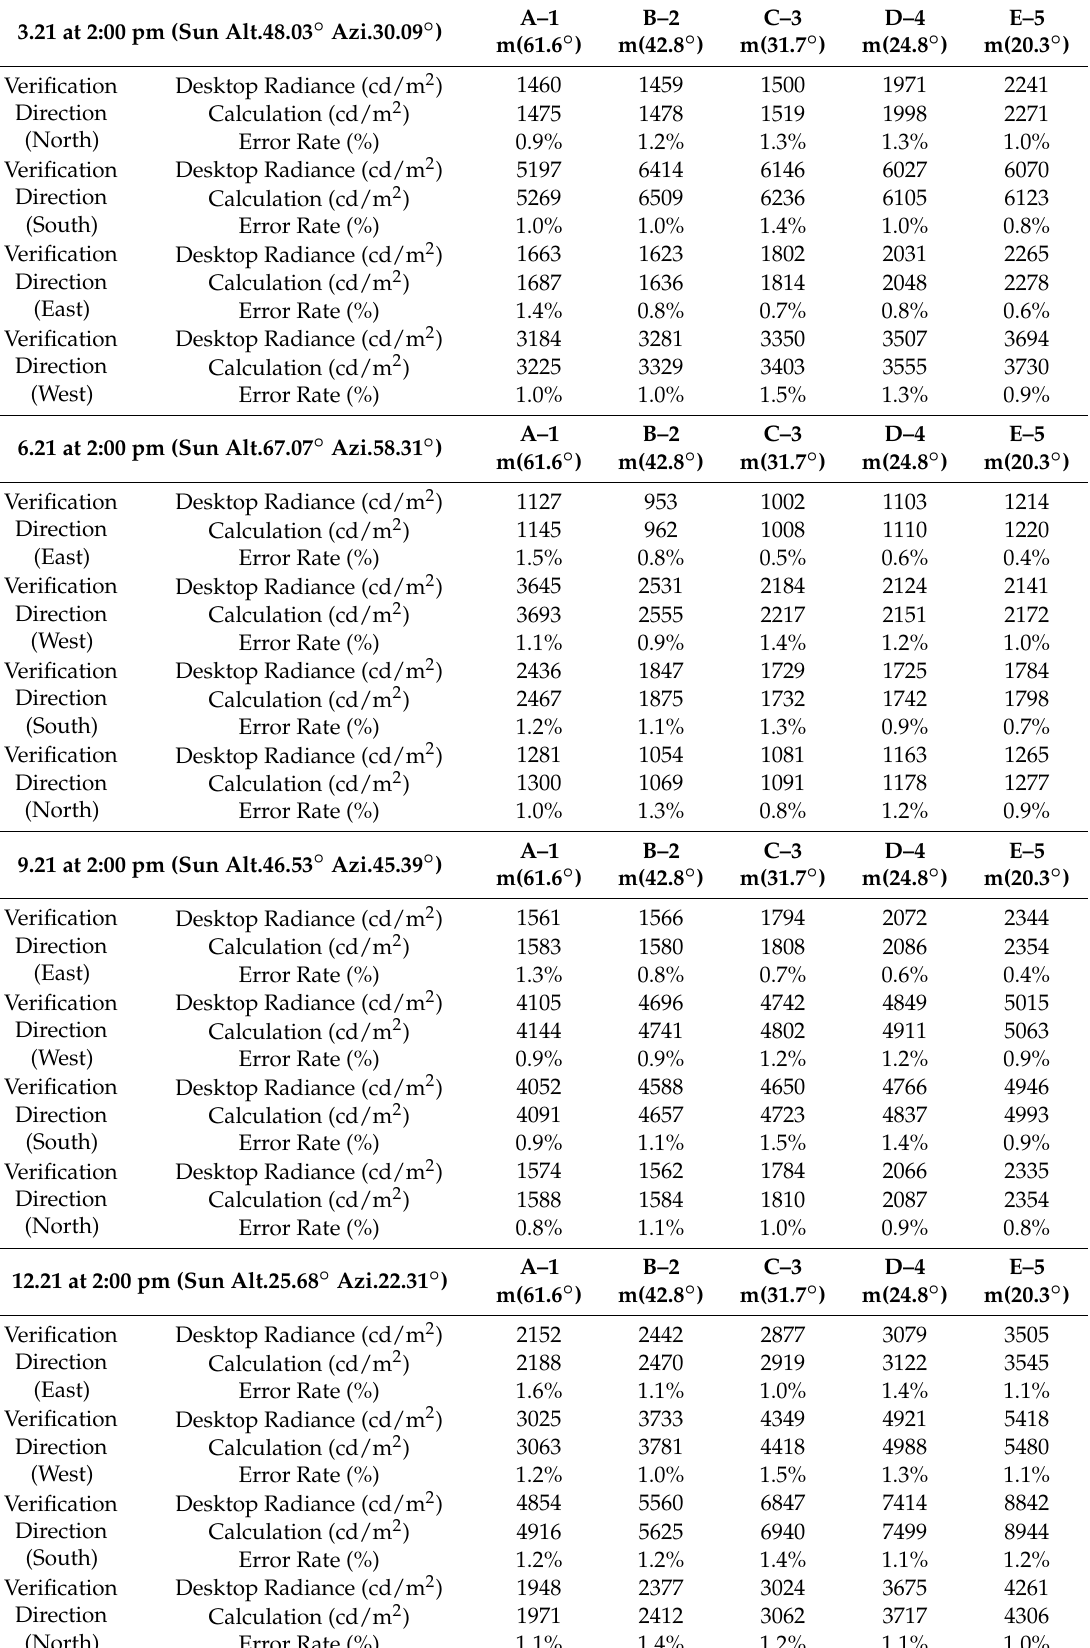
Table 11. Prediction results and error rate of sky luminance distributions in CIE clear